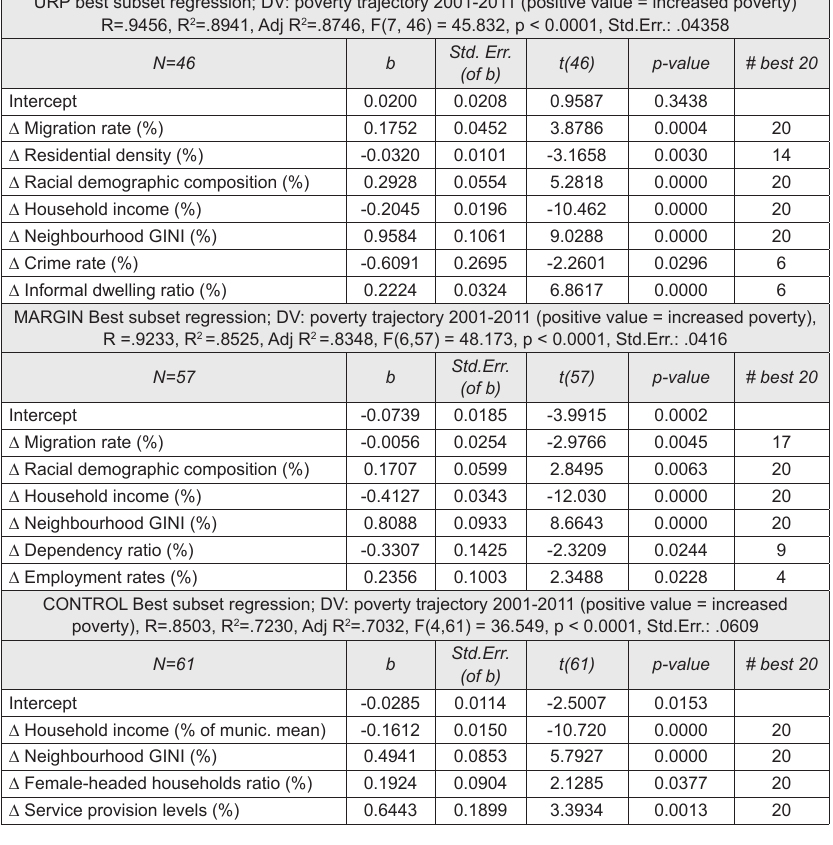
Table 3: Multiple regression analyses of factors related to changes in neighbourhood poverty, 2001-2011, in the URP, MABI and control areas,